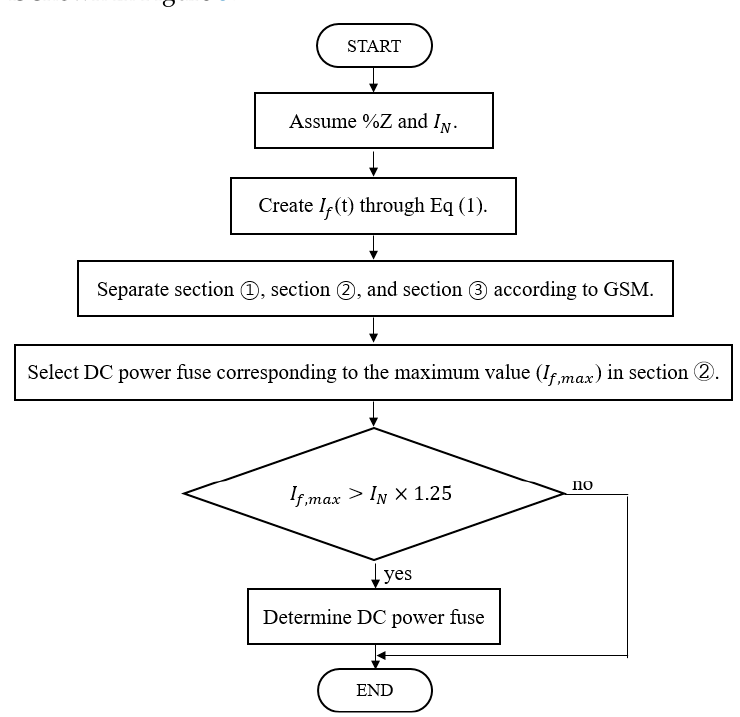
Figure 5. Decision of the proper capacity of DC power fuse.